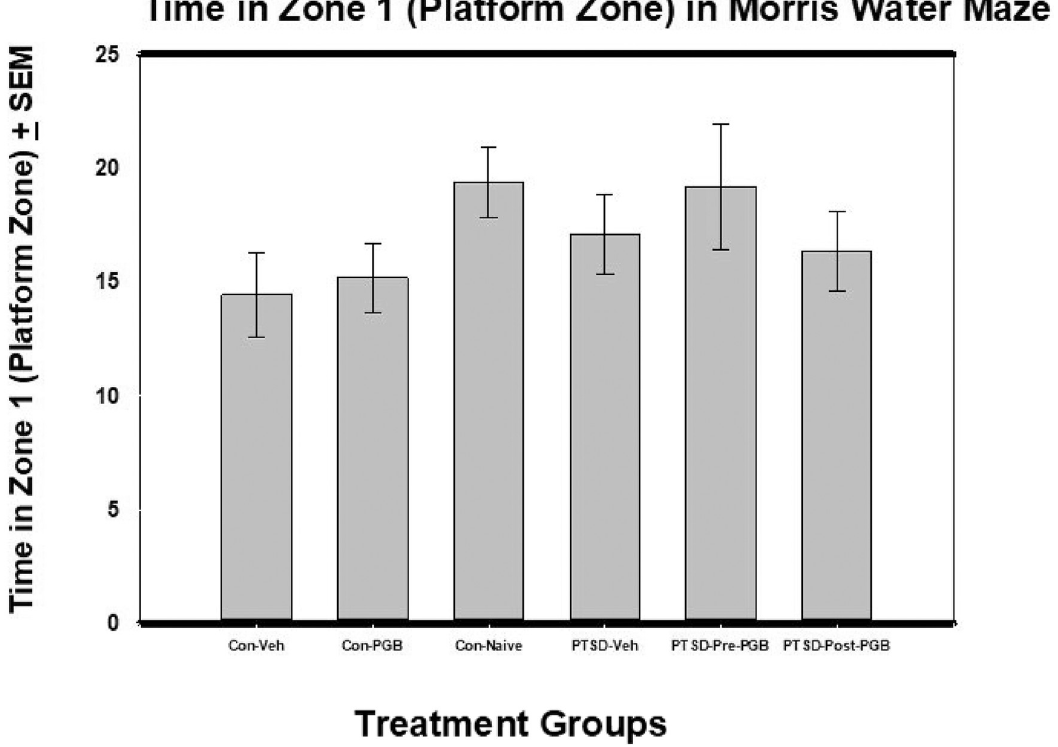
Fig 5. ANOVA of Time in Zone1 (Platform Zone) from Morris water maze (MWM) and Standard Error of the Mean (SEM). Each of the main two groups (Stressed and Non-stressed) had three subgroups: non-stressed: control vehicle, control PGB, control na ï ve; and stressed: Posttraumatic stress disorder (PTSD) vehicle, PTSD Pre-PGB (prophylactic), PTSD Post-PGB (non- prophylactic). Mean total body weight is reported with the standard error of the mean (SEM). There was not a significant difference between the six